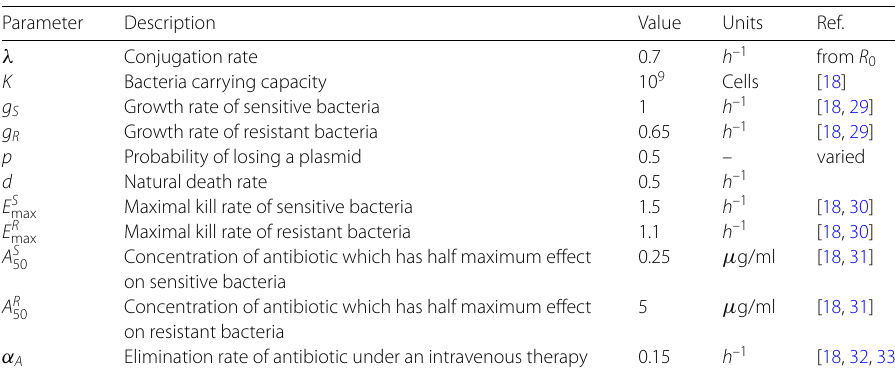
Table 1 Parameter values for the